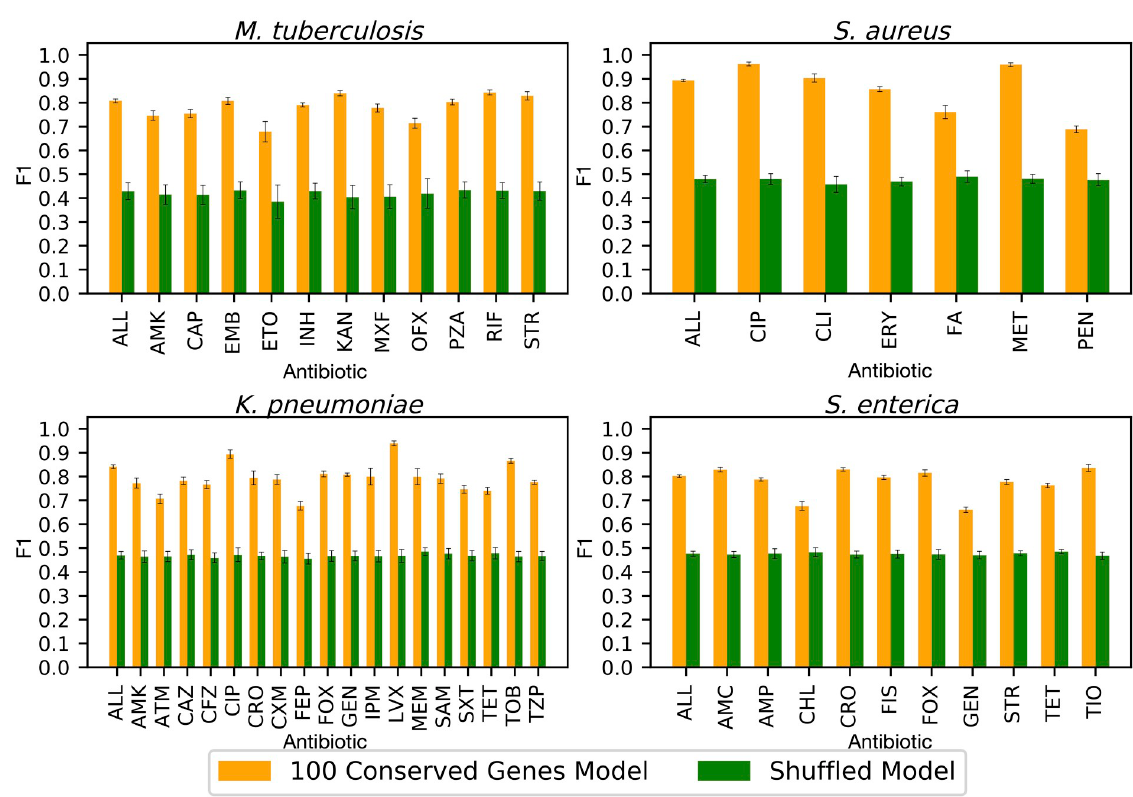
Fig 5. Average F1 scores by antibiotic for ten models built from non-overlapping sets of 100 core genes (orange bars) versus the same model where the AMR phenotypes have been randomized (green bars). Error bars represent the minimum and maximum 95% confidence observed in all ten replicates. Antibiotic abbreviations are defined in Table